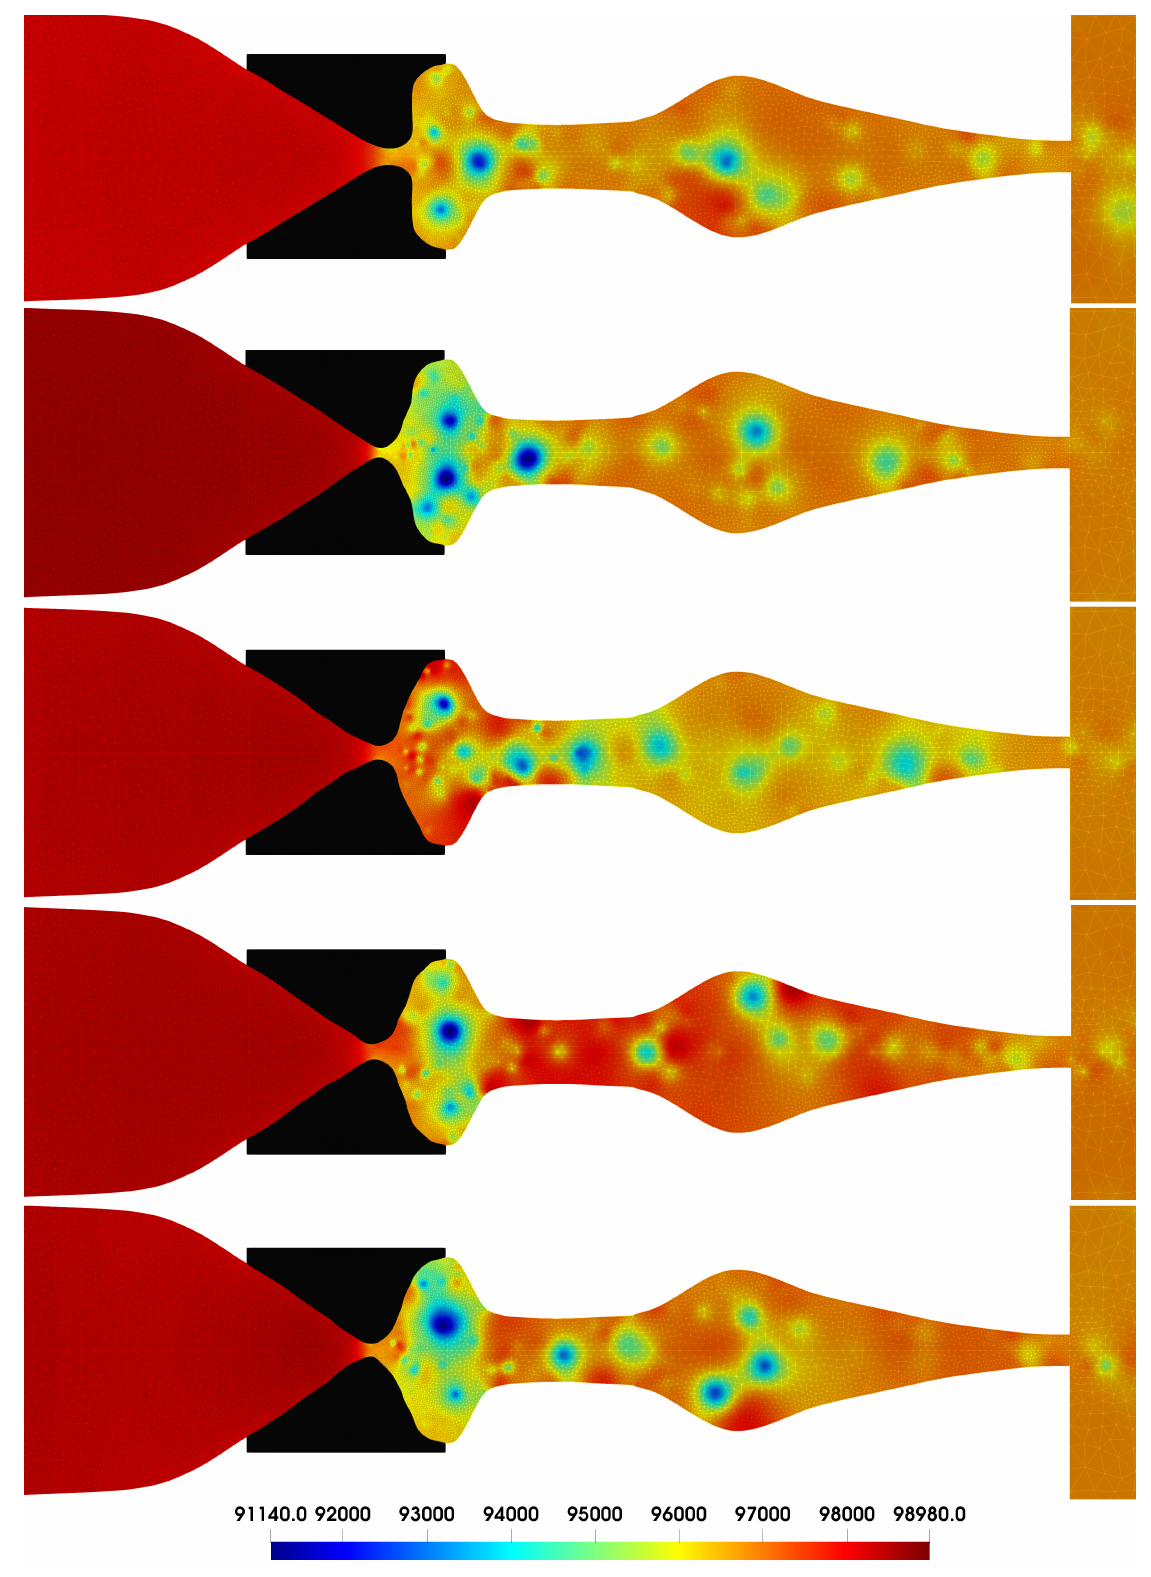
Figure 6. Distribution of the pressure in the glottal region at five time instants ( t = 0.0074,0.0084, 0.0094,0.0104,0.0114s) of the vocal folds